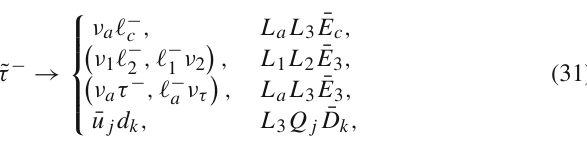
Table8 BestlimitsinRPVsearchesusingsimplifiedmodelsand ¯ U ¯ D ¯ D operators.Here a , b , c ∈ { 1 , 2 } .Thepair-producedsupersymmetricpar- ticles are assumed to decay directly to the neutralino LSP if not stated Particle Lower bound (GeV) ¯ U ¯ D ¯ D coupling Simpl.